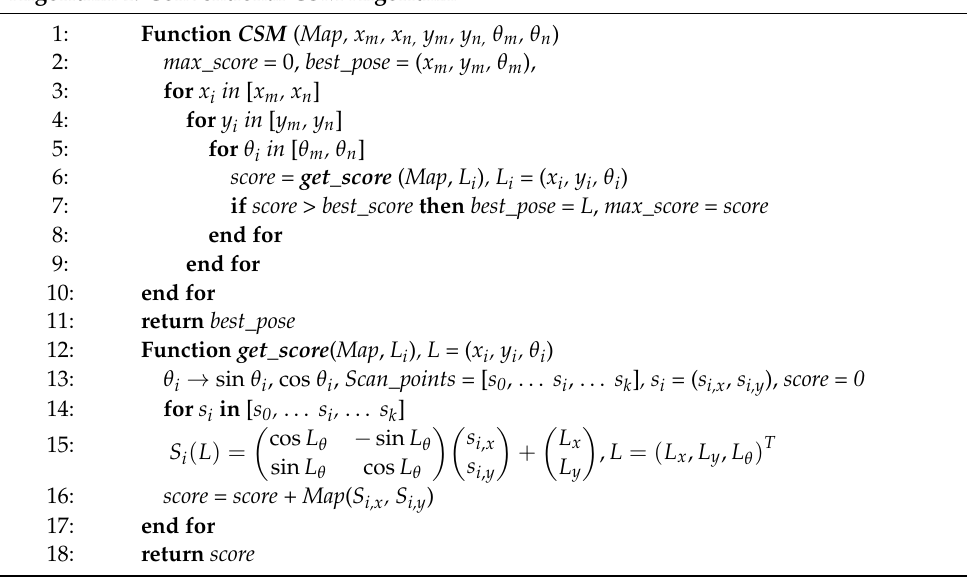
Algorithm 1: Conventional CSM Algorithm